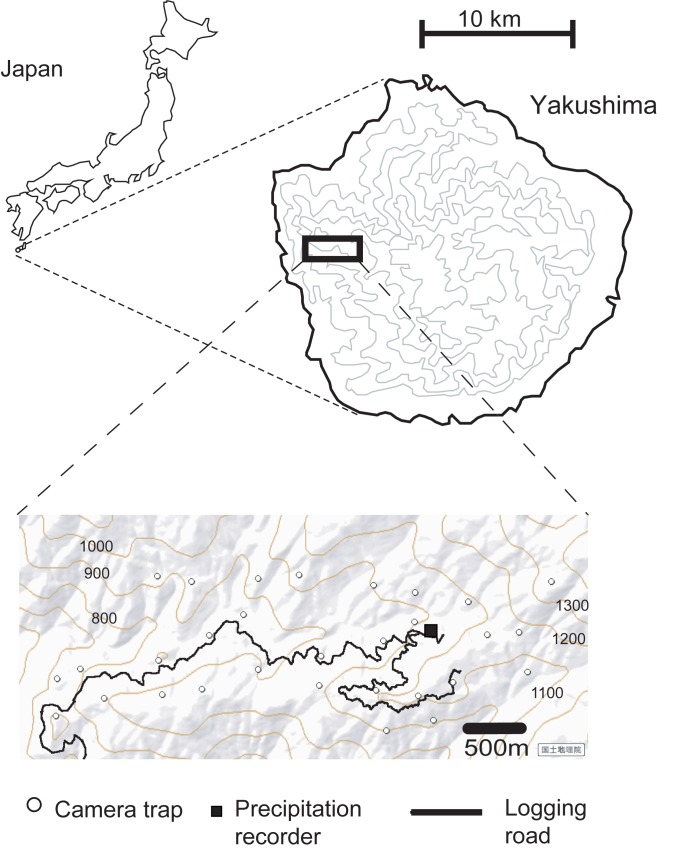
The location of Yakushima, the study area in Yakushima and the camera trapping sites.Contours were drawn every 300 m in the map of Yakushima. The map of the study sites was drawn based on a map provided by the Geospatial Information Authority of Japan.